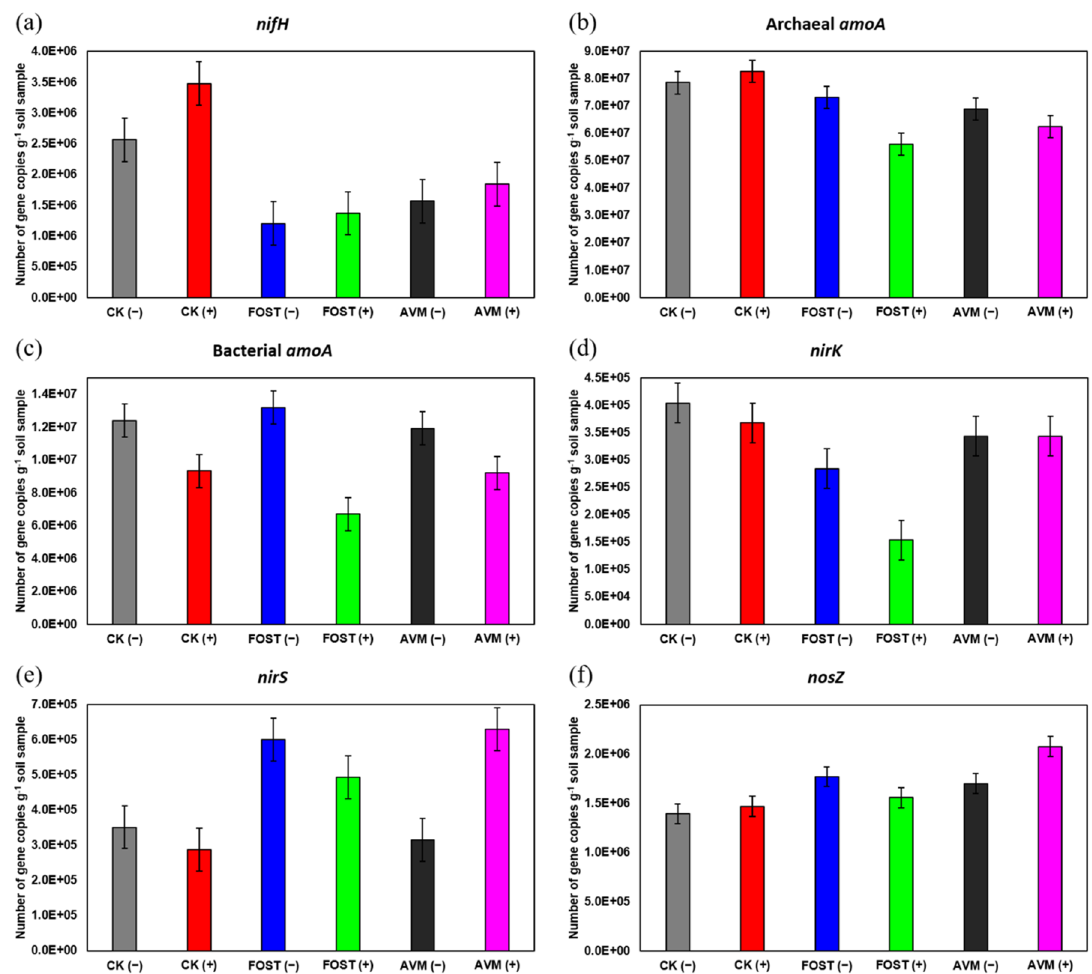
Figure 6. Quantitative PCR of nitrogen-cycling gene abundances. The abundance of six N-cycling genes involved in nitrogen fixation (a, nifH ), ammonia oxidation by archaea (b, archaeal amoA ) and bacteria (c, bacterial amoA ), and denitrification (d-f, nirK , nirS , nosZ ) in different treatments. CK: control; FOST: fosthiazate; AVM: avermectin. (+ /−) stands for with and without B418 inoculation. Error bar indicates standard error at P = 0.05 in the ANOVA test for microbial